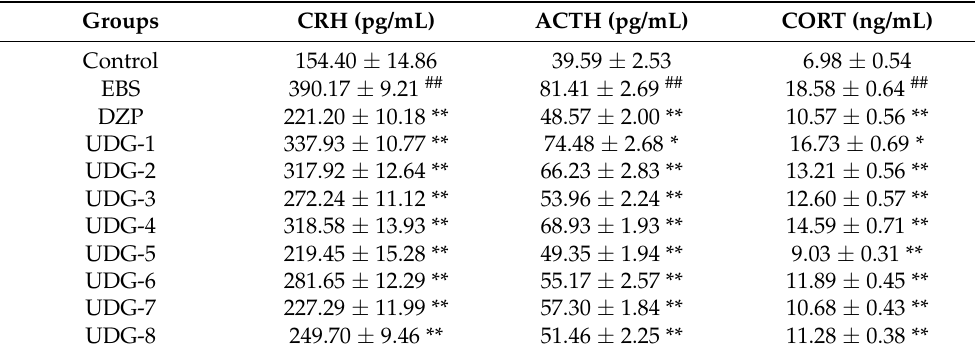
Table 2. Uniform designed experiment—multiple pharmacodynamic indicators in serum ( n = 8–10; mean ± SEM).